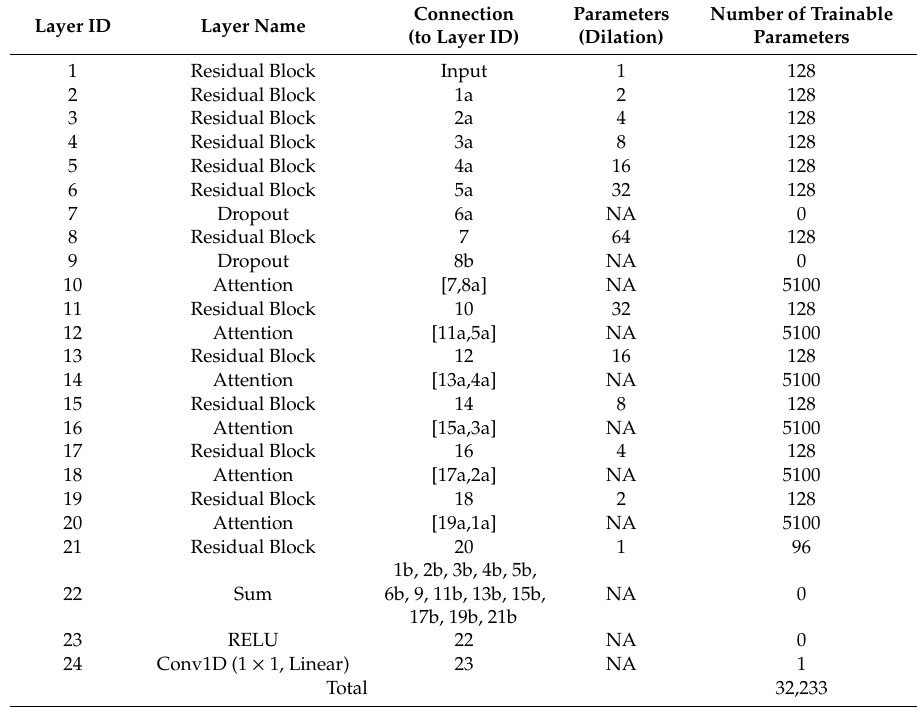
Table 7. Residual attention U-net (ResAUnet) hyperparameters.